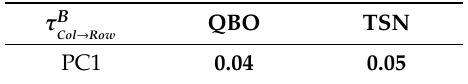
Table 5. IF τ B values between PC1 and the low-frequency climate indices (bold font indicates Col → Row statistically significant values at the 5% level).